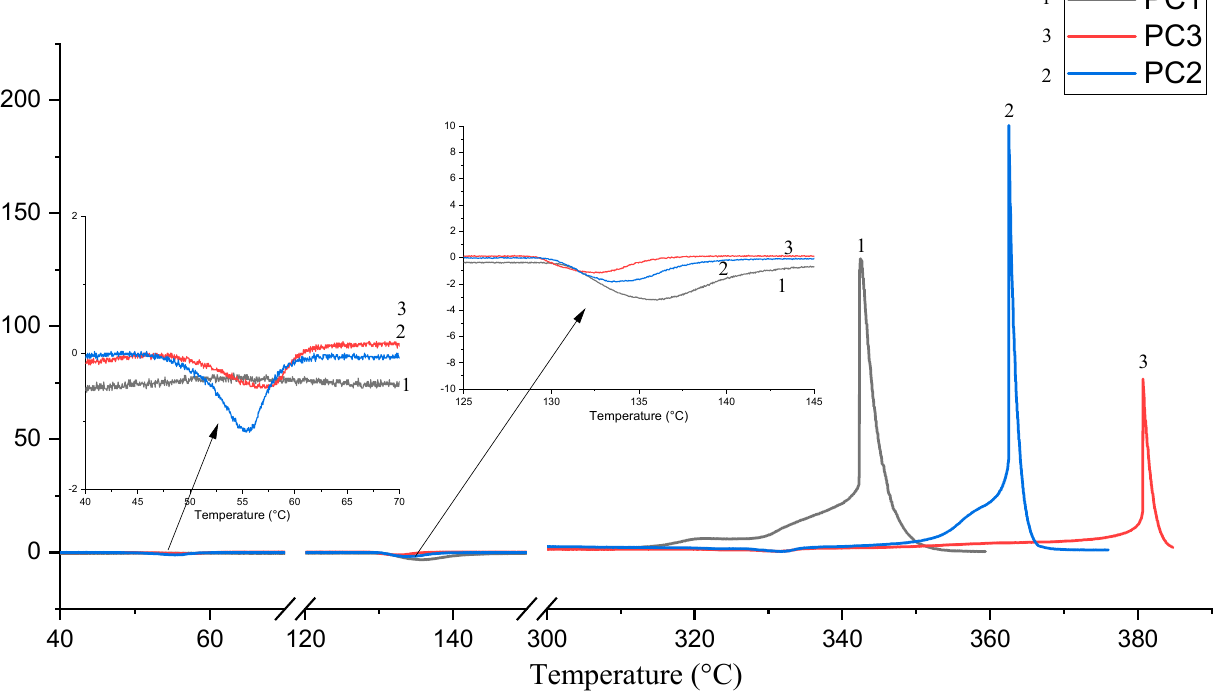
Figure 3. DTA thermogram of the smoke compositions.